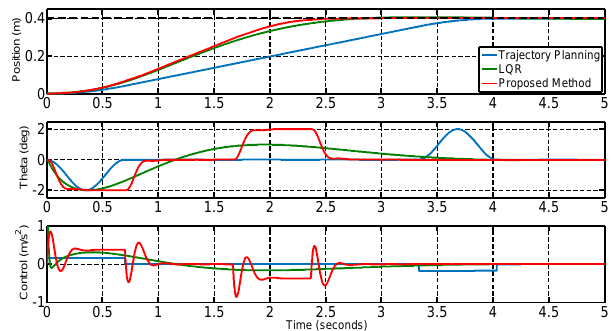
Figure 7. Control response of trajectory planning (TP), linear quadratic regulator (LQR), and the proposed method.